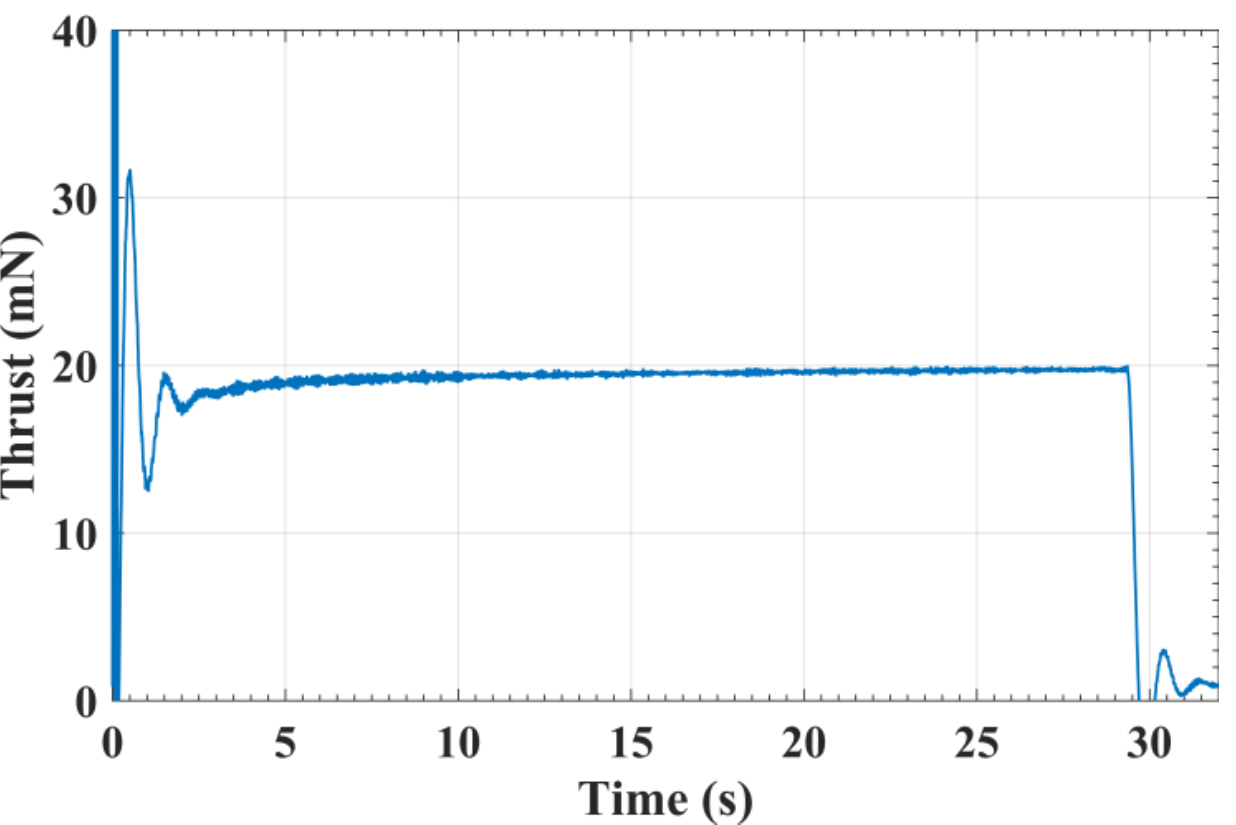
Figure 4. Thrust as a function of time at 200 V discharge voltage and anode flow of 1.82 mg/s.